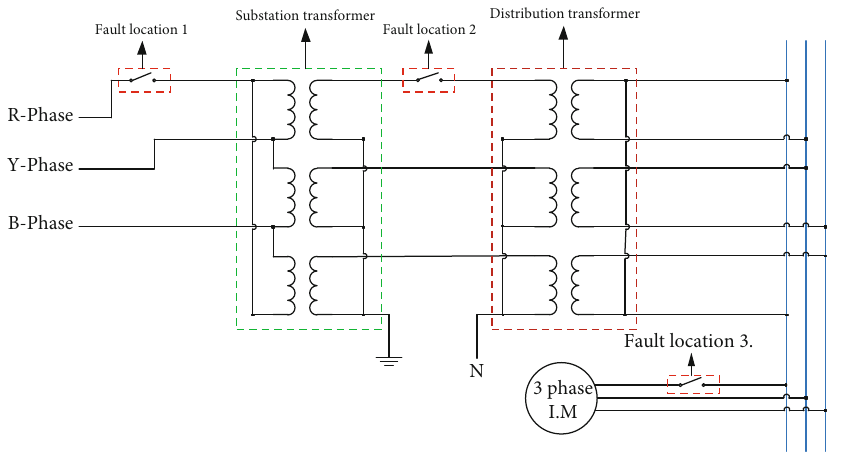
Figure 1: Single phasing fault at substation and distribution